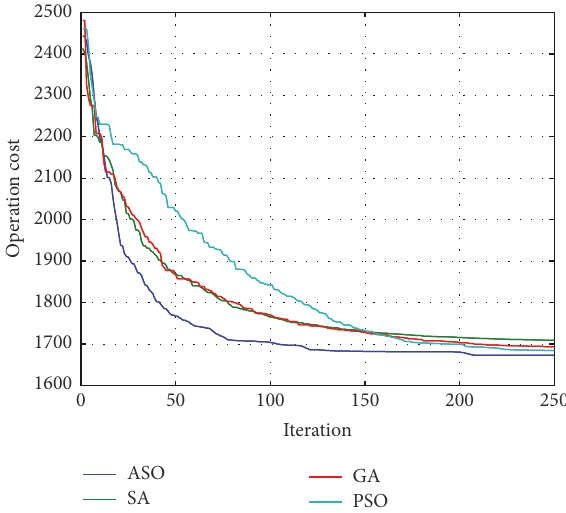
Figure 8: Convergence graph of ASO, SA, GA, and PSO for Case 1.